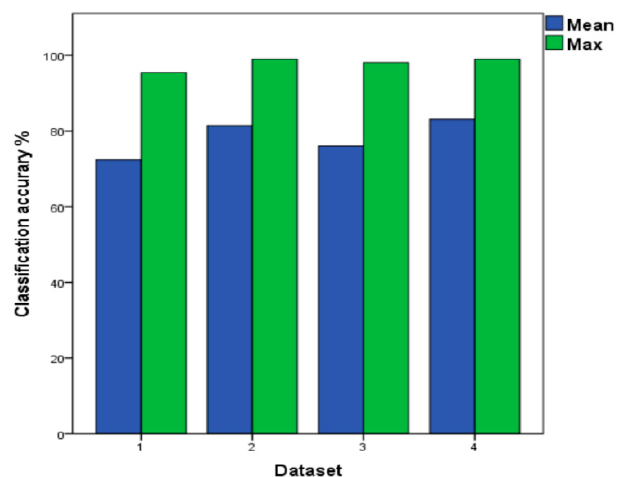
Figure 9. The Mean and Maximum Values of SVM under the Four Datasets. Green: the highest classification accuracy in every dataset; Blue: the average classification accuracy in every dataset.